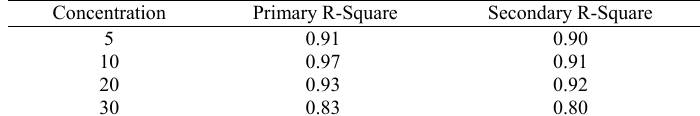
The theoretically calculated values of interfacial tension are shown in Table 4. Based on this table, the interfacial tension is increased as concentration of Na SO increased. When the concentration of 2 4 Na SO increased the chance of collision between 2 4 reactant ions increased and interfacial tension is increased, therefore induction time is decreased according to Eq.2. If the interfacial tension calculation is applied on different types of stabilizers as plotted in